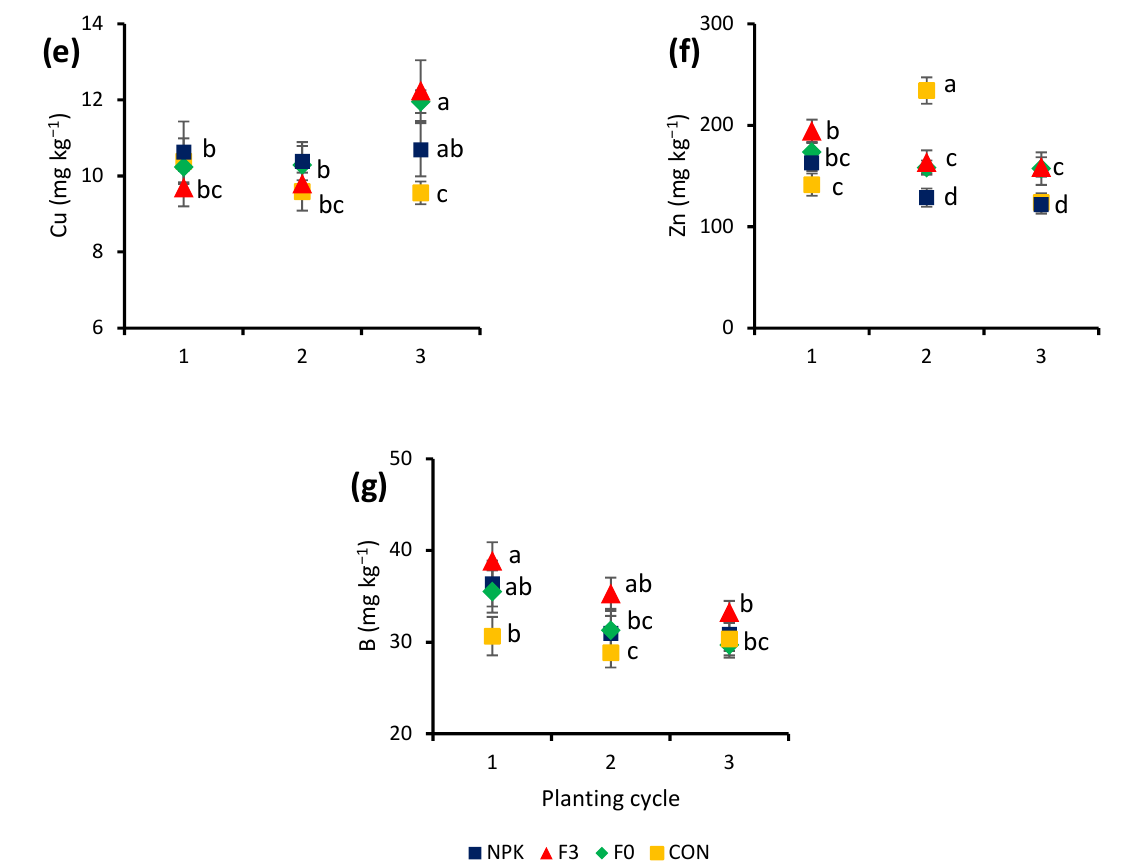
Figure 5. Means ( ± SE) interaction between treatments and the planting cycle on plant nutrient: ( a ) P, ( b ) K, ( c ) Ca, ( d ) Mg, ( e ) Cu, ( f ) Zn, and ( g ) B. On the same chart, means with the same letter(s) within the same chart are not significantly different ( p > 0.05) from one another using Tukey’s test.